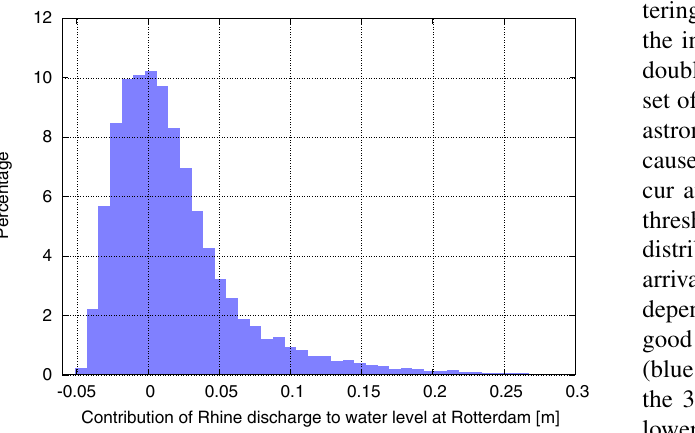
Figure 6. Histogram of the effect of the Rhine discharge on the water level at Rotterdam. The bin width is